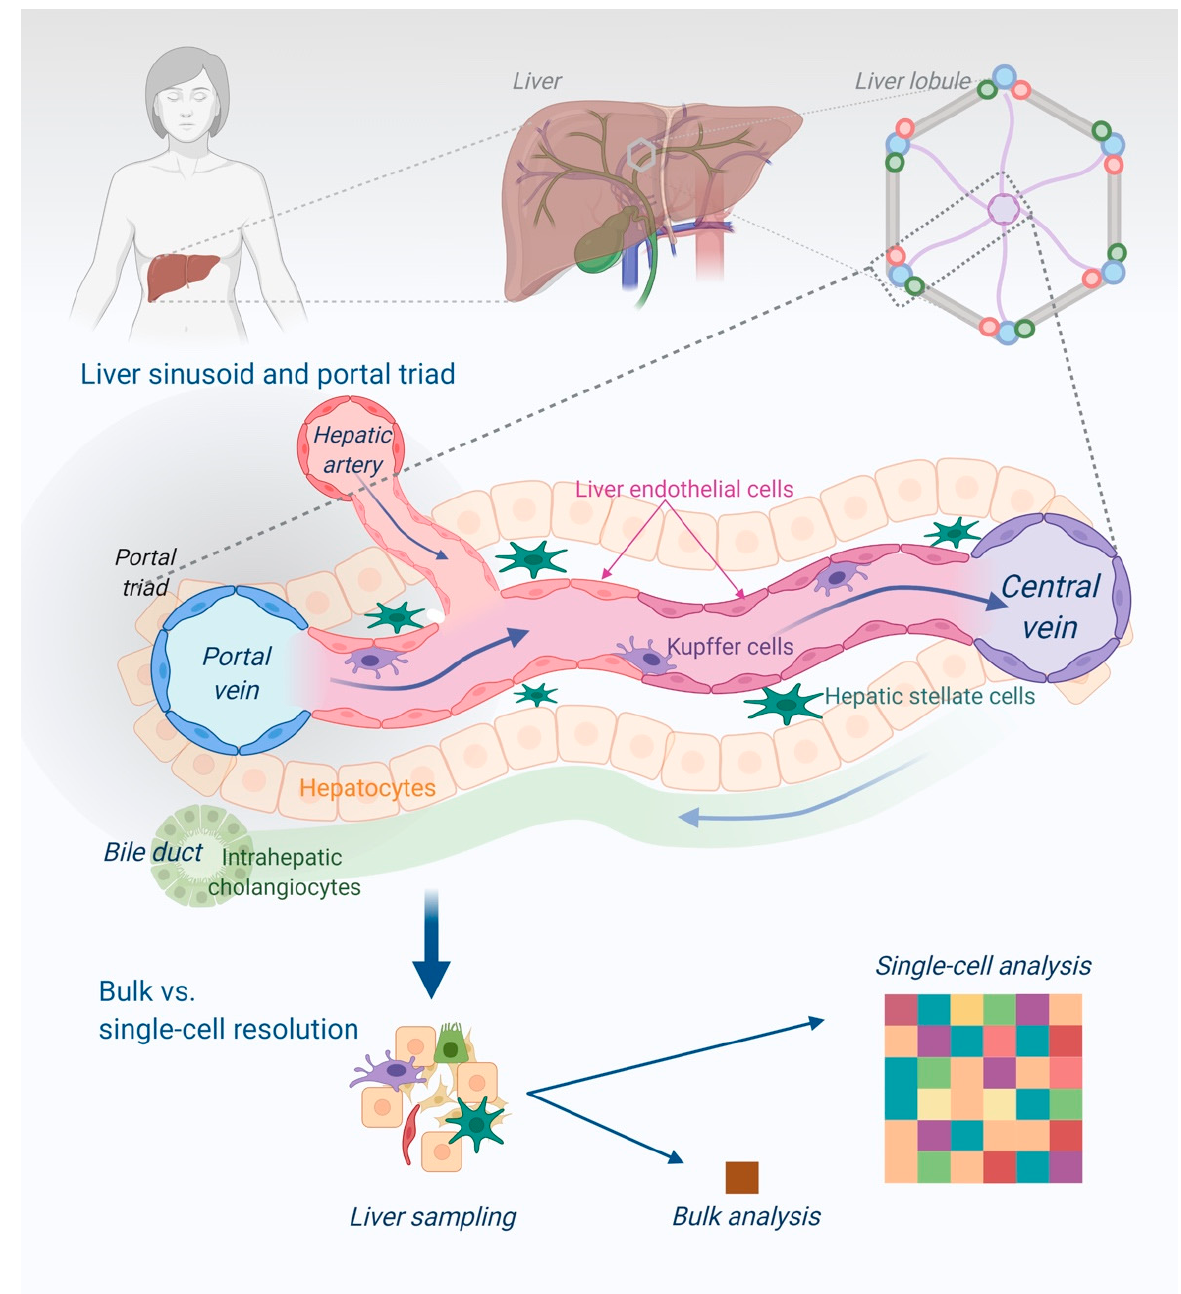
Figure 3. The structure of a liver lobule, its zonation and different cell types highlights the advantage of single-cell analysis. Healthy hepatic lobules are zonated from the portal triads (portal vein, hepatic artery, and bile duct) towards the central vein. Oxygenated, arterial blood and nutrient-rich portal venous blood enters the lobule from the portal triad, and is transported back to the circulation via a central vein.